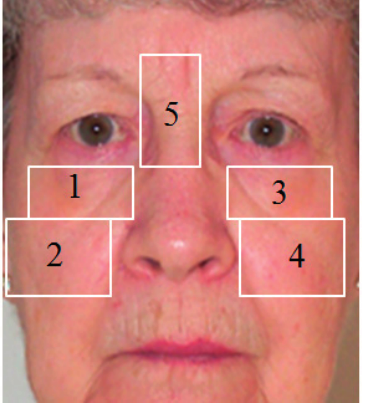
Figure 15. Example of several selected local wrinkle regions to extract wrinkle